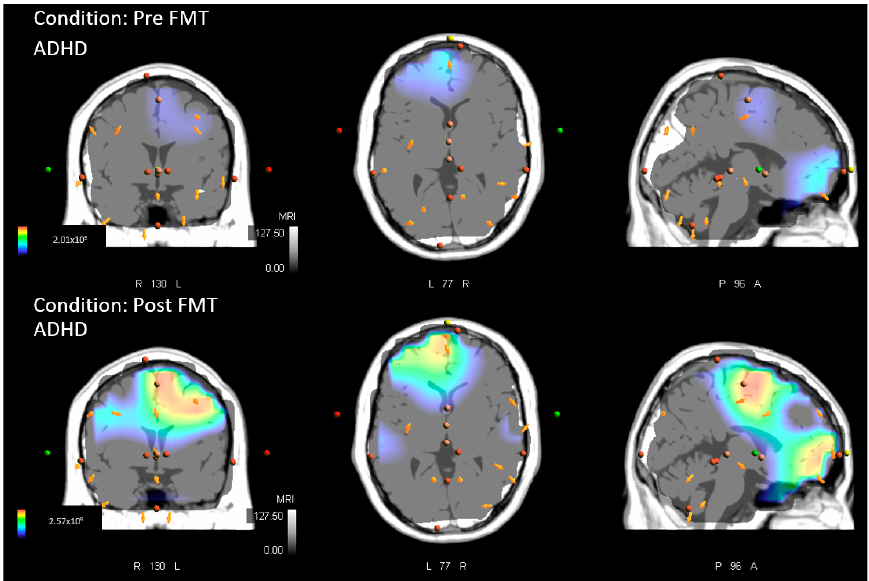
Figure 3. Sources of neural activity in those with ADHD at baseline (pre) measures and at post- measures after participants completed the FMT. Latency coincides with the differential image created using sLORETA (Figure 1). Cross-sectional areas include the coronal (left), transverse (middle), and sagittal plane (right).